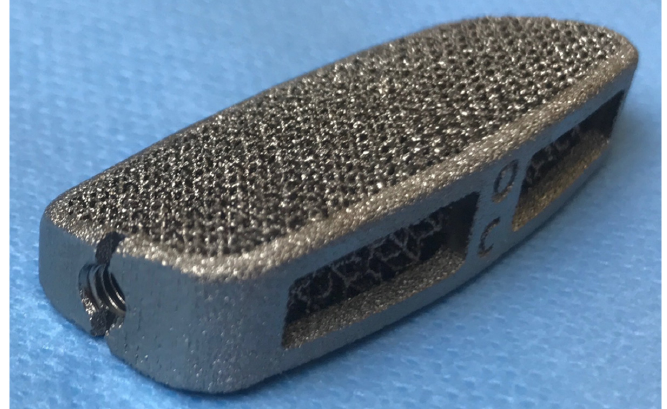
Figure 1. Custom-made trabecular titanium cage for XLIF surgery.